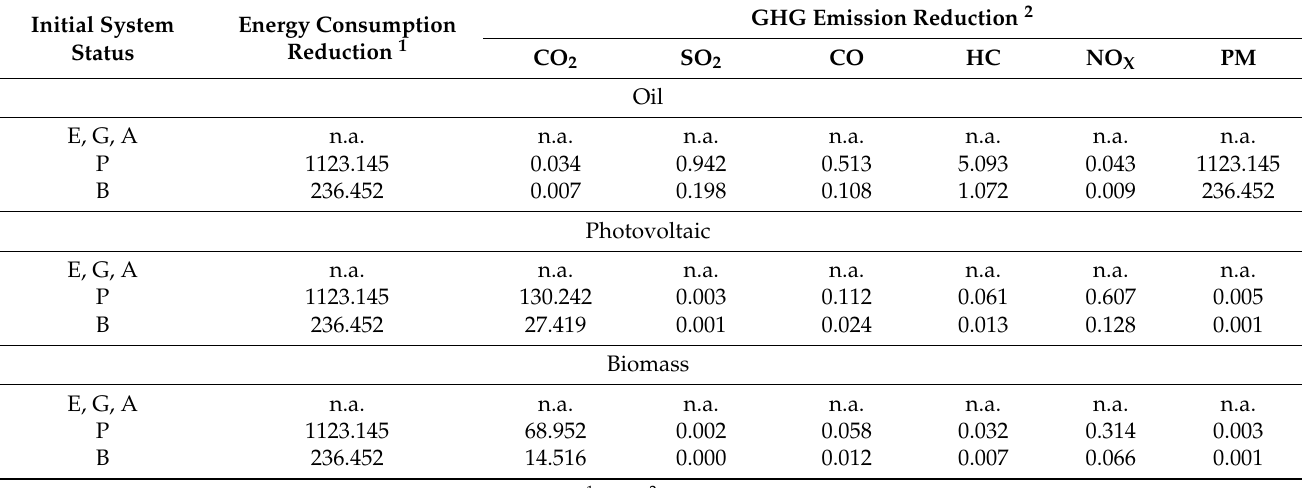
Table 13. Energy consumption reduction and GHG emission reduction resulting from the second iteration of maintenance policy optimization within the whole time-window of analysis in the case of electricity generation source oil, photovoltaic, and biomass.